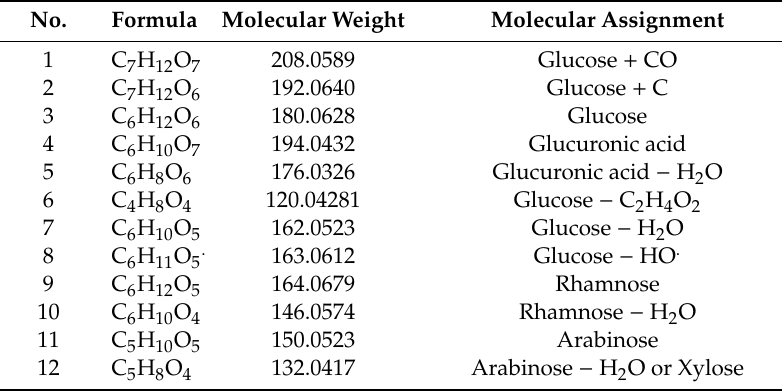
Table 2. Characteristic neutral loss of flavonoid